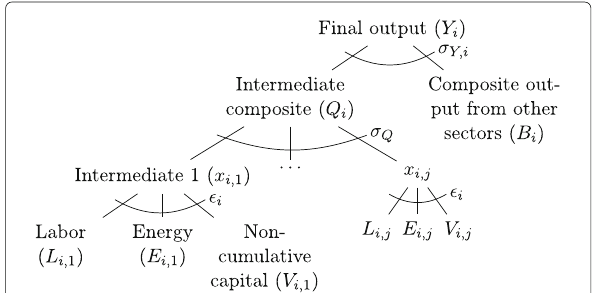
Fig. 1 Nested production function of regular sector i